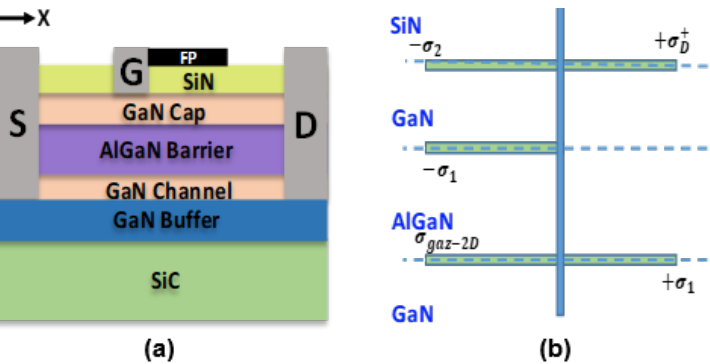
Figure 4. ( a ) Typical 2D structure of the AlGaN/GaN HEMT (0.15 um gate length) used in the simulations. ( b ) Distribution of polarization charges at each material interface.